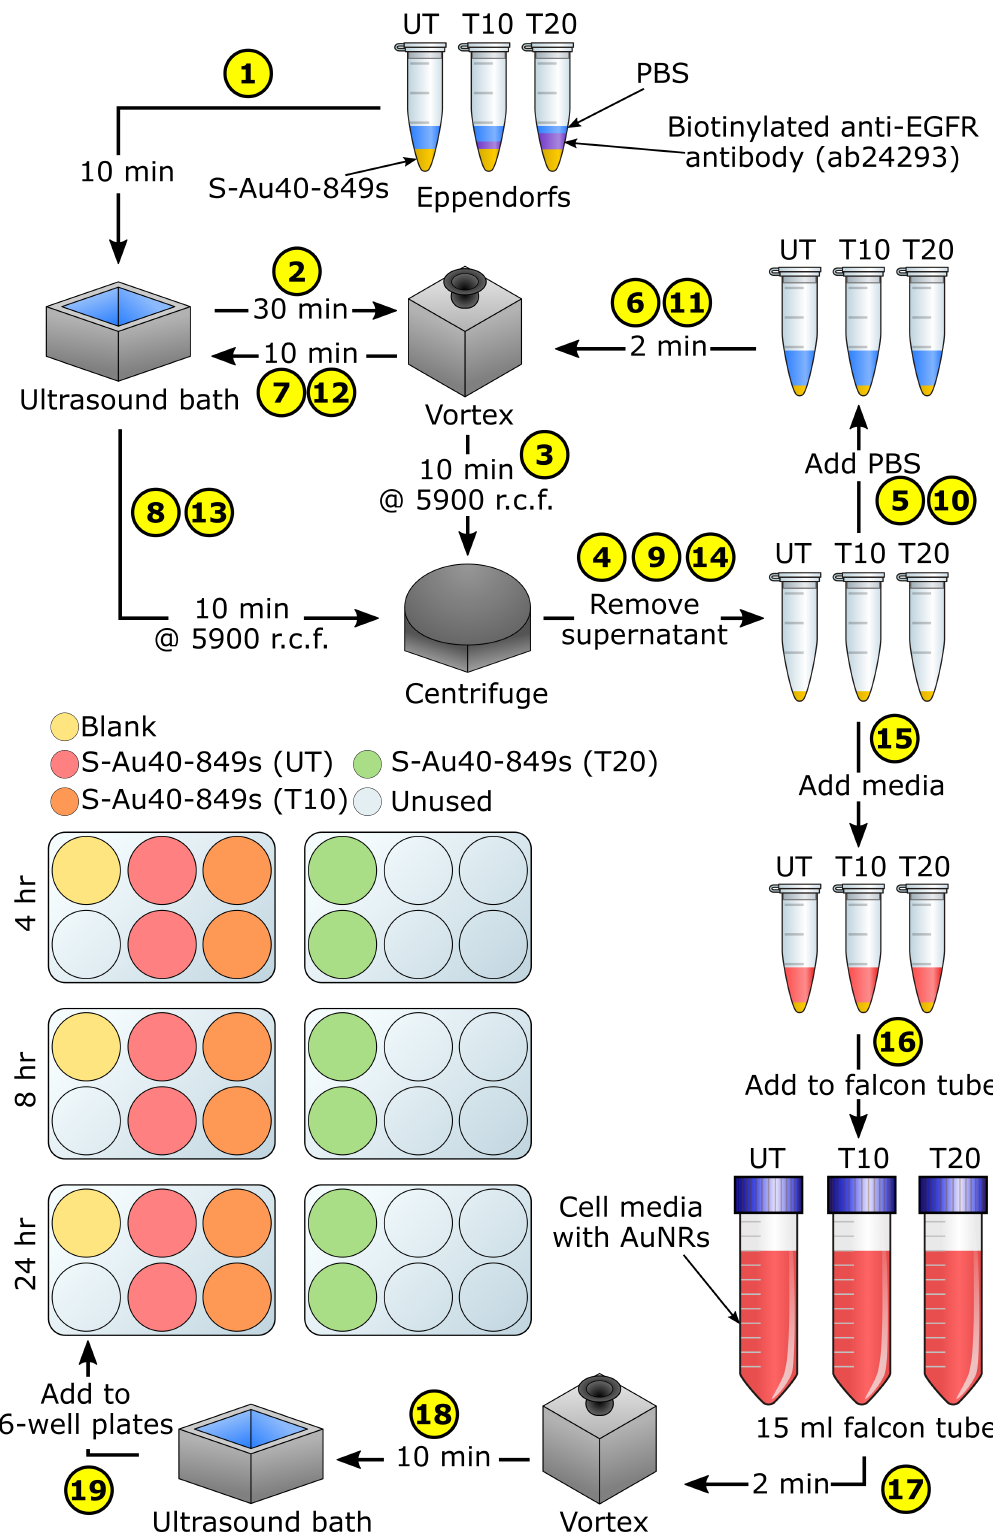
Figure 3. A schematic depicting the functionalisation process for the S-Au40-849s. UT = untargeted AuNRs, T10 = targeted AuNRs (10µL antibody), T20 = targeted AuNRs (20µL